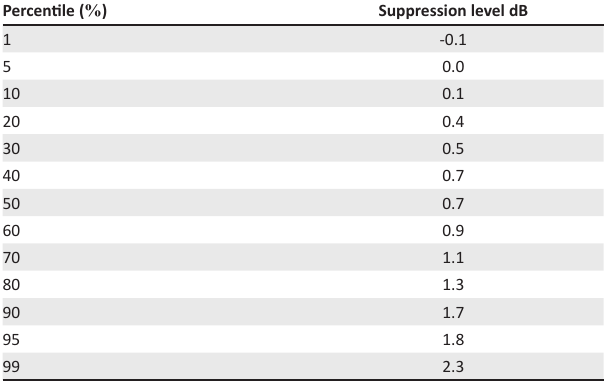
TABLE 5: Normative data for the percentile values of suppression level for a transient evoked otoacoustic emission’s click. Percentile ( % )